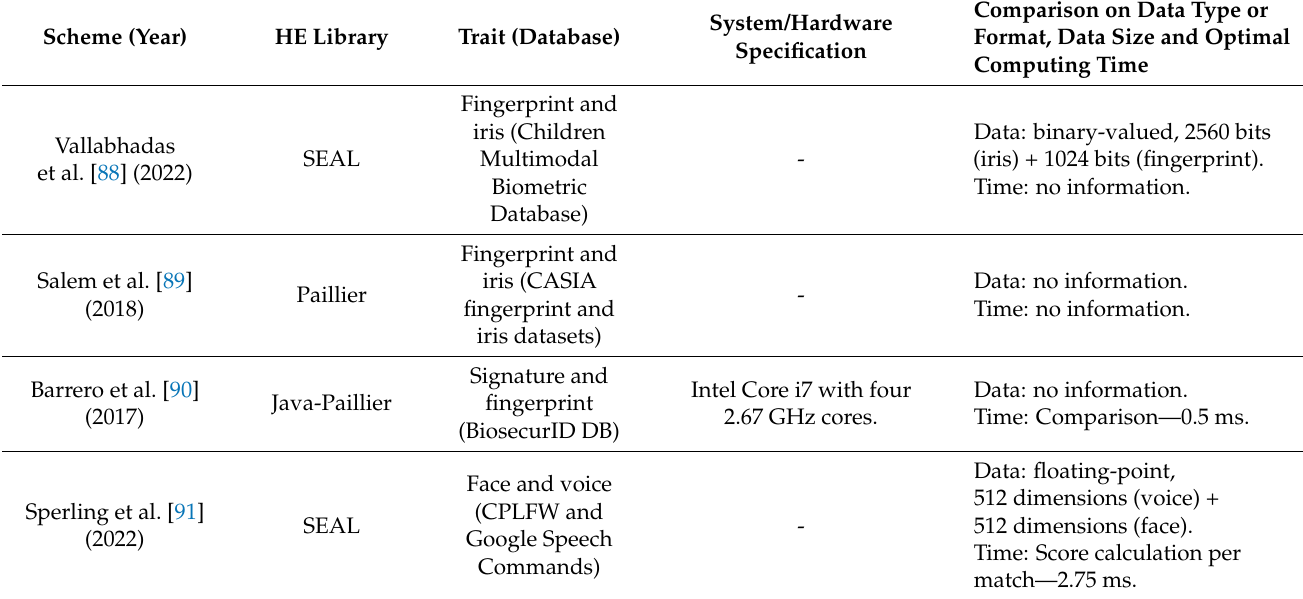
Table 6. Comparison of HE-based approaches to multimodal biometric security in terms of computa- tional